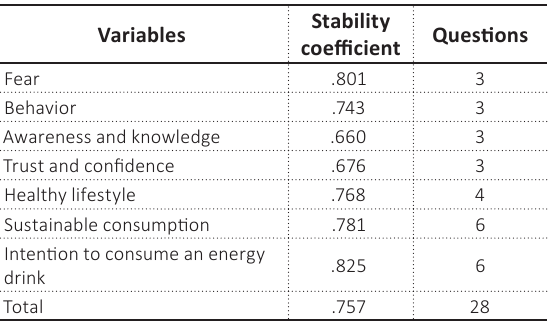
Table 1. Internal consistency coefficients